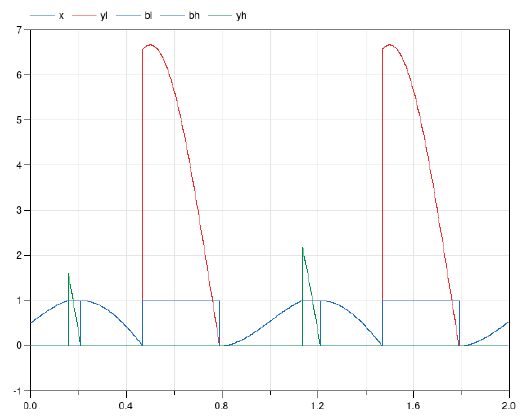
Figure 30. Simulation of the Water Tank system in RIMIS form with Dymola